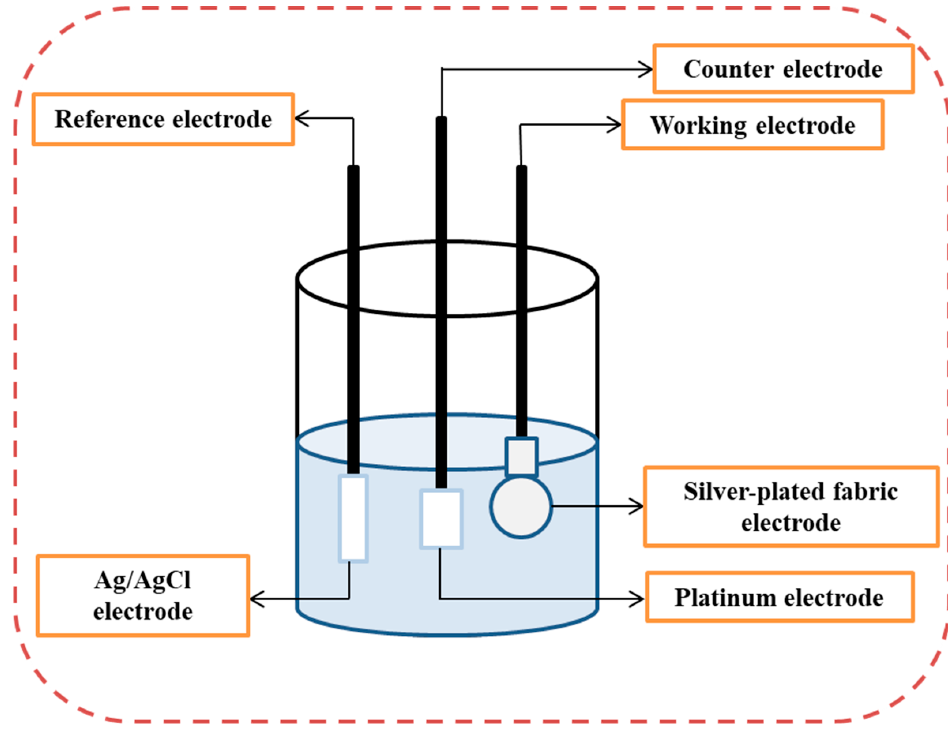
Figure 2. Schematic diagram of electroplating process device.